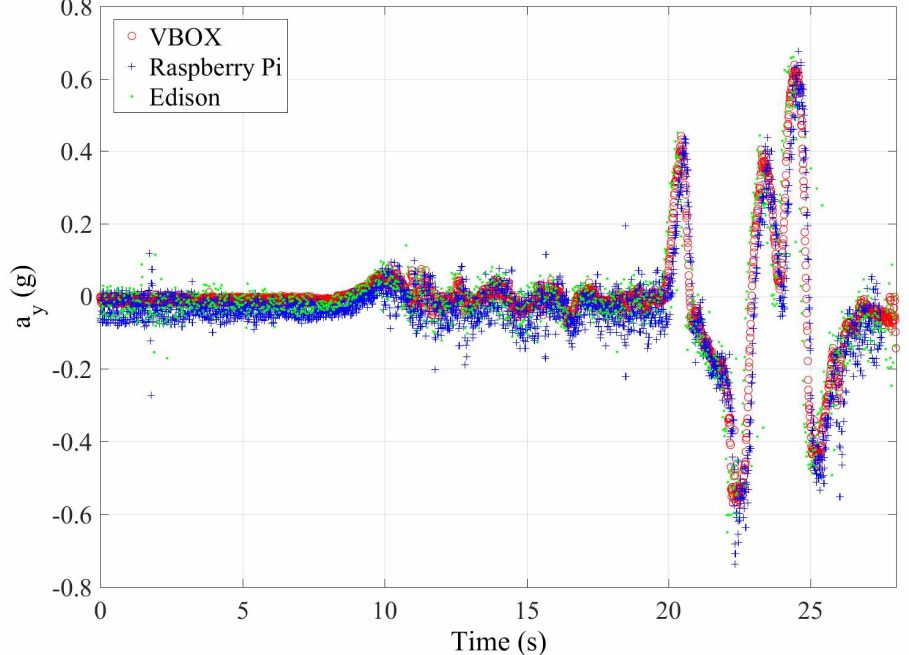
Figure 11. Test 2: Lateral acceleration obtained from the IMU of VBOX (red points), from the IMU of Raspberry pi (blue points) and from the IMU from Intel Edison (green points).